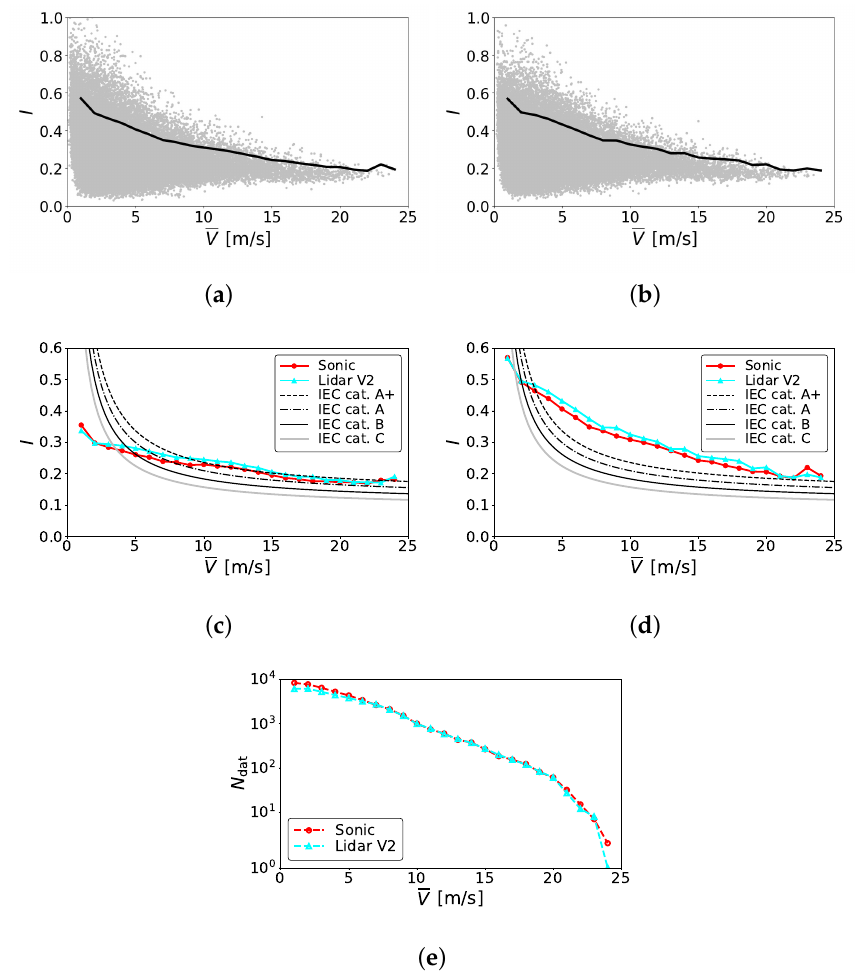
Figure 10. Turbulence intensity as a function of mean wind speed at 57 m height. ( a ) Sonic anemometer; ( b ) V2 profiling LiDAR; ( c ) bin-averaged turbulence intensities; ( d ) turbulence intensity for the 90th percentile of the standard deviation for the wind speed bin; ( e ) number of 10-min average data per bin. Lines in ( a , b ) represent the 90th percentile of the standard deviation for the wind speed bin. Bin size is set to 1 m/s of mean wind